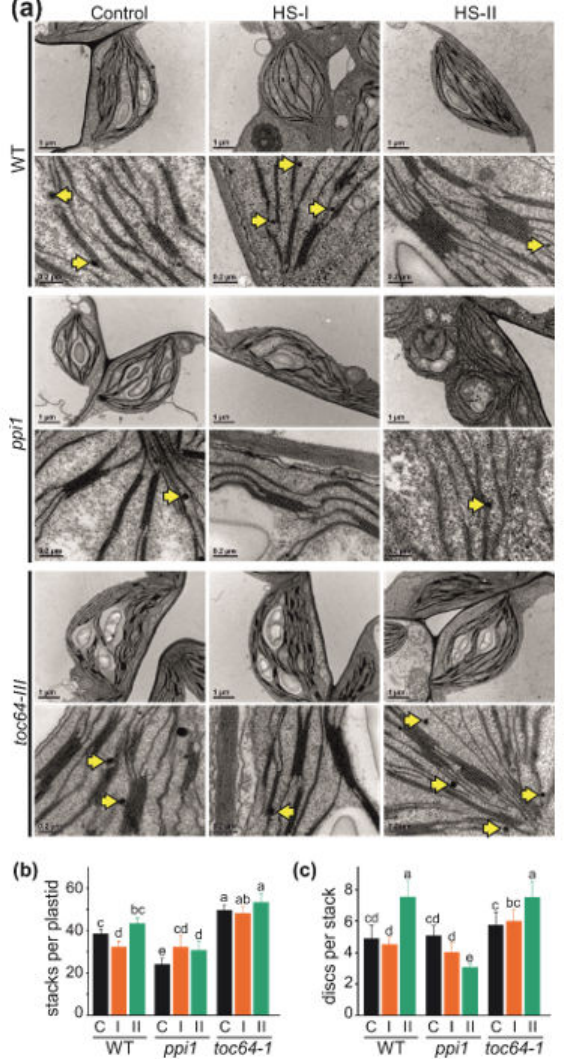
Figure 2. Chloroplast ultrastructure of heat-stress-treated wild-type, ppi1 , and toc64-1 plants. ( a ) The leaves of 21-day-old plants were analyzed. Representative images of each line and condition are shown in two magnifications (11,500 × : complete chloroplast and 66,000 × : for stacks). Scale bar for each image shows 1 µ m for the 11,500 × fold magnification and 0.2 µ m for 66,000 × fold magnification. Plastoglobules are marked by yellow arrows. ( b , c ) The number of grana stacks and discs per grana stack was counted for each plant line (at least four chloroplasts per plant line per condition). Significance ( p < 0.05; n = 5) determined by statistical analysis (ANOVA with Duncan post hoc test) is